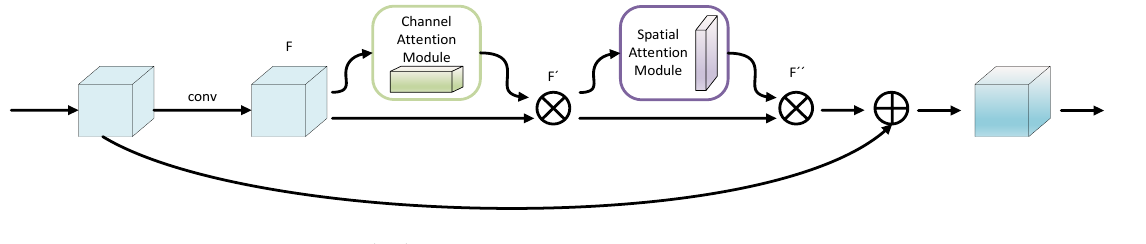
Figure 6. Residual CBAM.